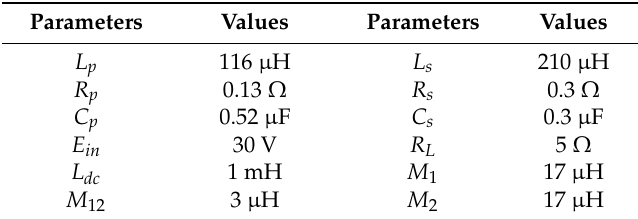
Table 2. Main simulation parameters of PS-type DEU-WPT system. Table 3. Main simulation parameters of PS-type WPT